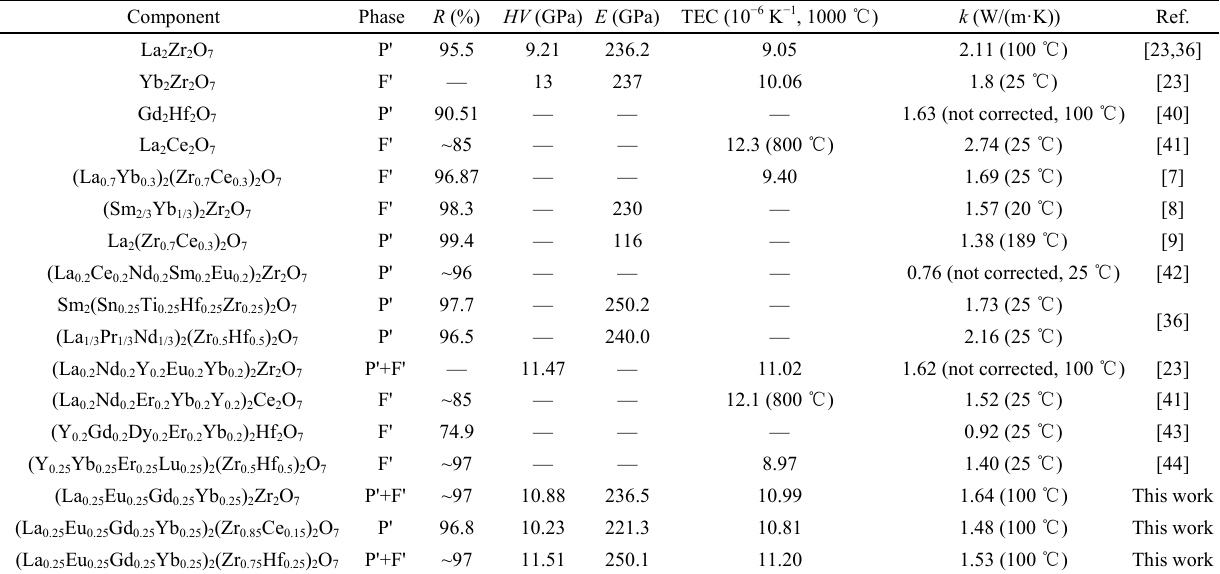
Table 3 Mechanical and thermophysical properties of A 2 B 2 O 7 ceramics